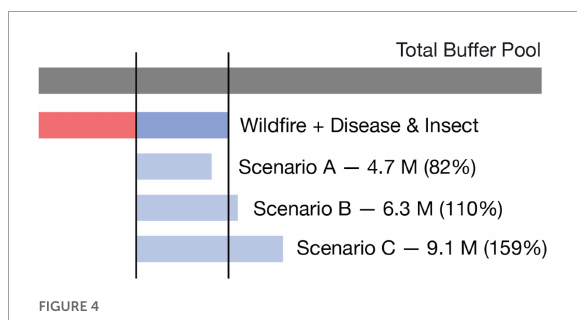
FIGURE4 Carbon liabilities from sudden oak death. The potential liability from tanoak mortality caused by sudden oak death is large enough to encumber the entire buffer pool contribution set aside for all disease and insect risks over 100 years. Scenario A shows illustrative losses assuming 50 percent tanoak mortality, but only in relatively cool tanoak forests; Scenario B shows illustrative losses assuming 50 percent tanoak mortality, but only in forests that contain both tanoak and California bay laurel,